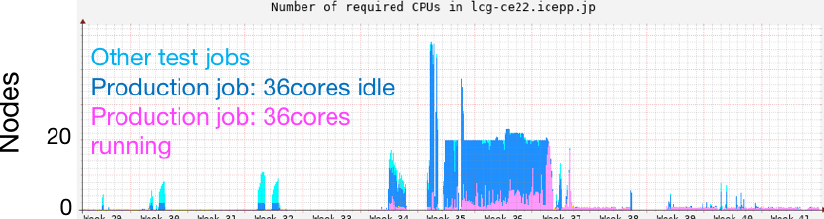
Figure 6. Test jobs running on the hybrid system using